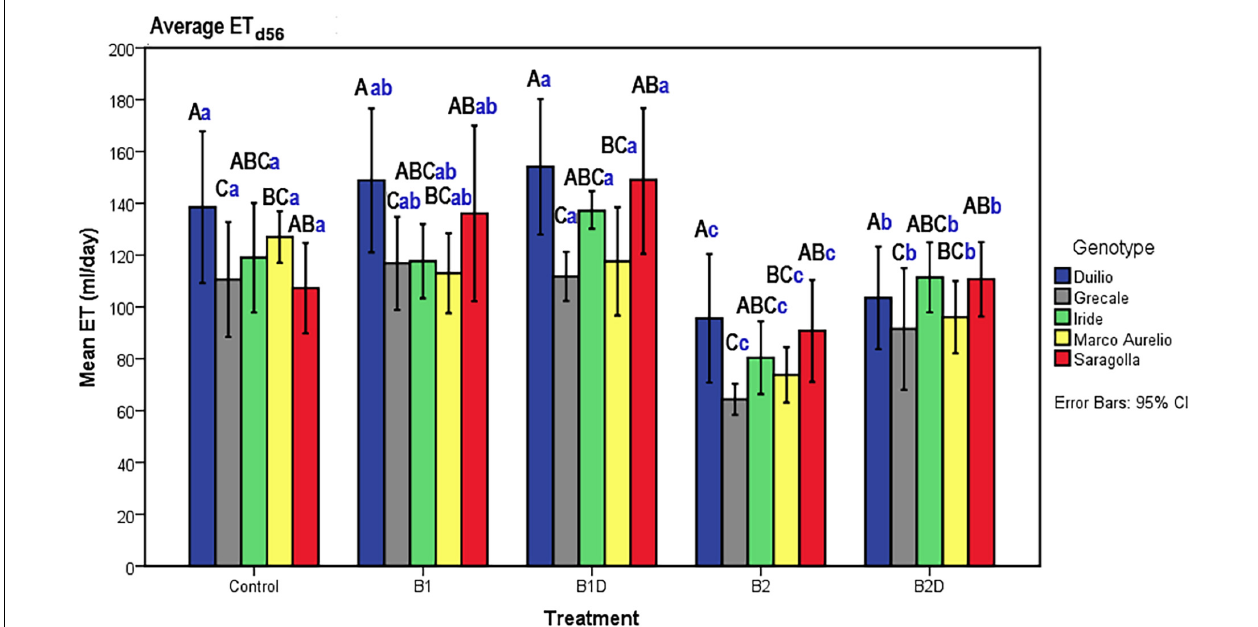
FIGURE 4 | ET on day 56, close to T f , as a function of genotype and treatment. Bars represent mean values, with error bars denoting 95% CI. Different bold letters indicate significant differences according to the R-E-G-W-Q test at the p < 0.001 level, with the black uppercase letters referring to the “genotype” subset and the blue lowercase ones to the “treatment” subset ( Supplementary Material 4